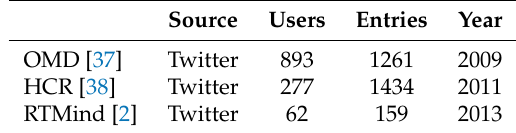
Table 1. Datasets used in the experiments. OMD, Obama–McCain Debate; HCR, Health Care Reform. Source